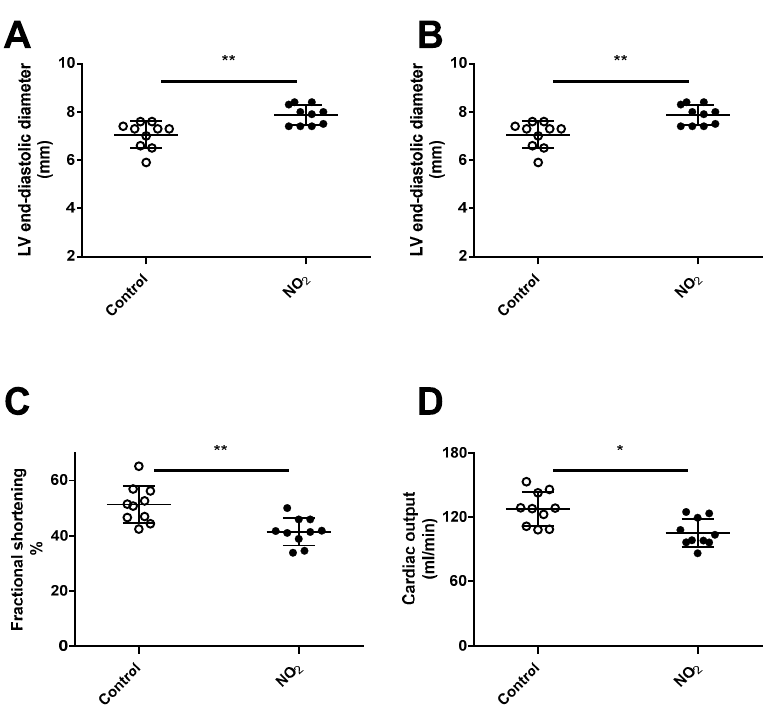
Figure 5. Echocardiographic parameters after repeated NO 2 exposures. Echocardiographic assessments were performed at 1-day post-exposure after 3 weeks (3 h/day, 5 days/week) of NO 2 exposures. The diagram shows echocardiographic measurements of left ventricle (LV) end-diastolic diameter ( A ), LV end-systolic diameter ( B ), LV fractional shortening ( C ) and cardiac output ( D ). * p < 0.05, ** p < 0.01, vs. control.